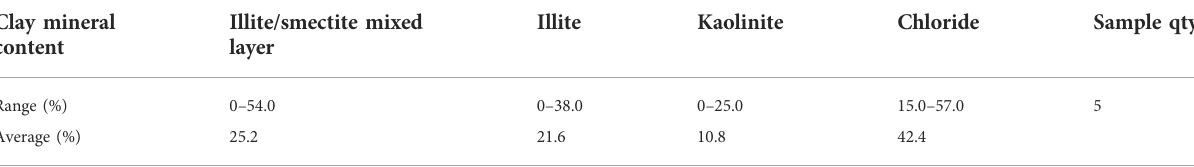
TABLE 2 Clay mineral content of the Upper Wuerhe Formation of Dinan 15 well block based on XDR. Clay mineral content